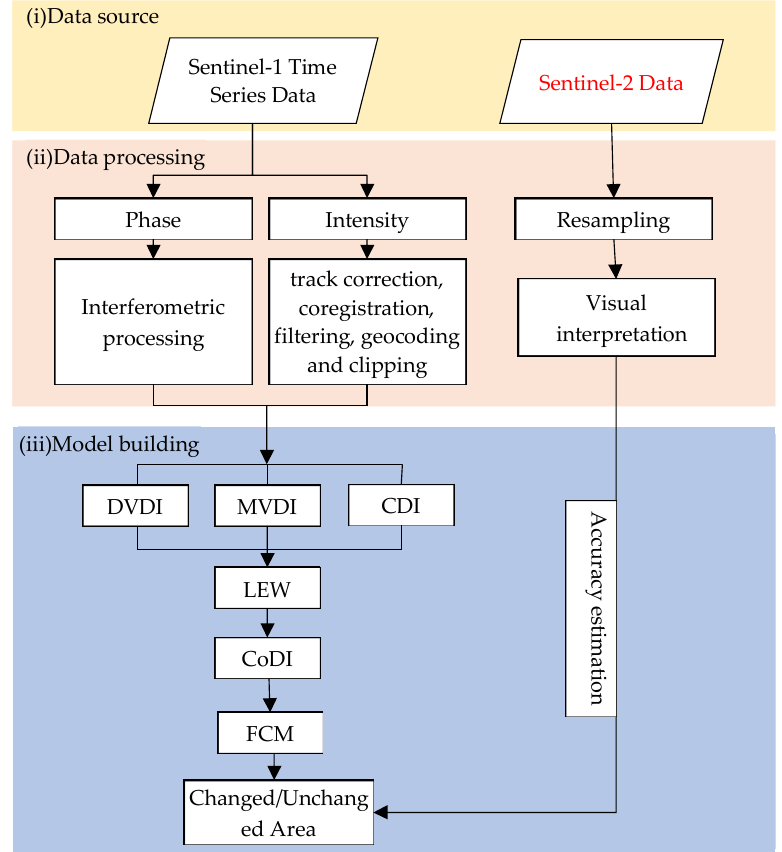
Figure 3. Flow chart of LEW change detection using Sentinel-1 SAR data.